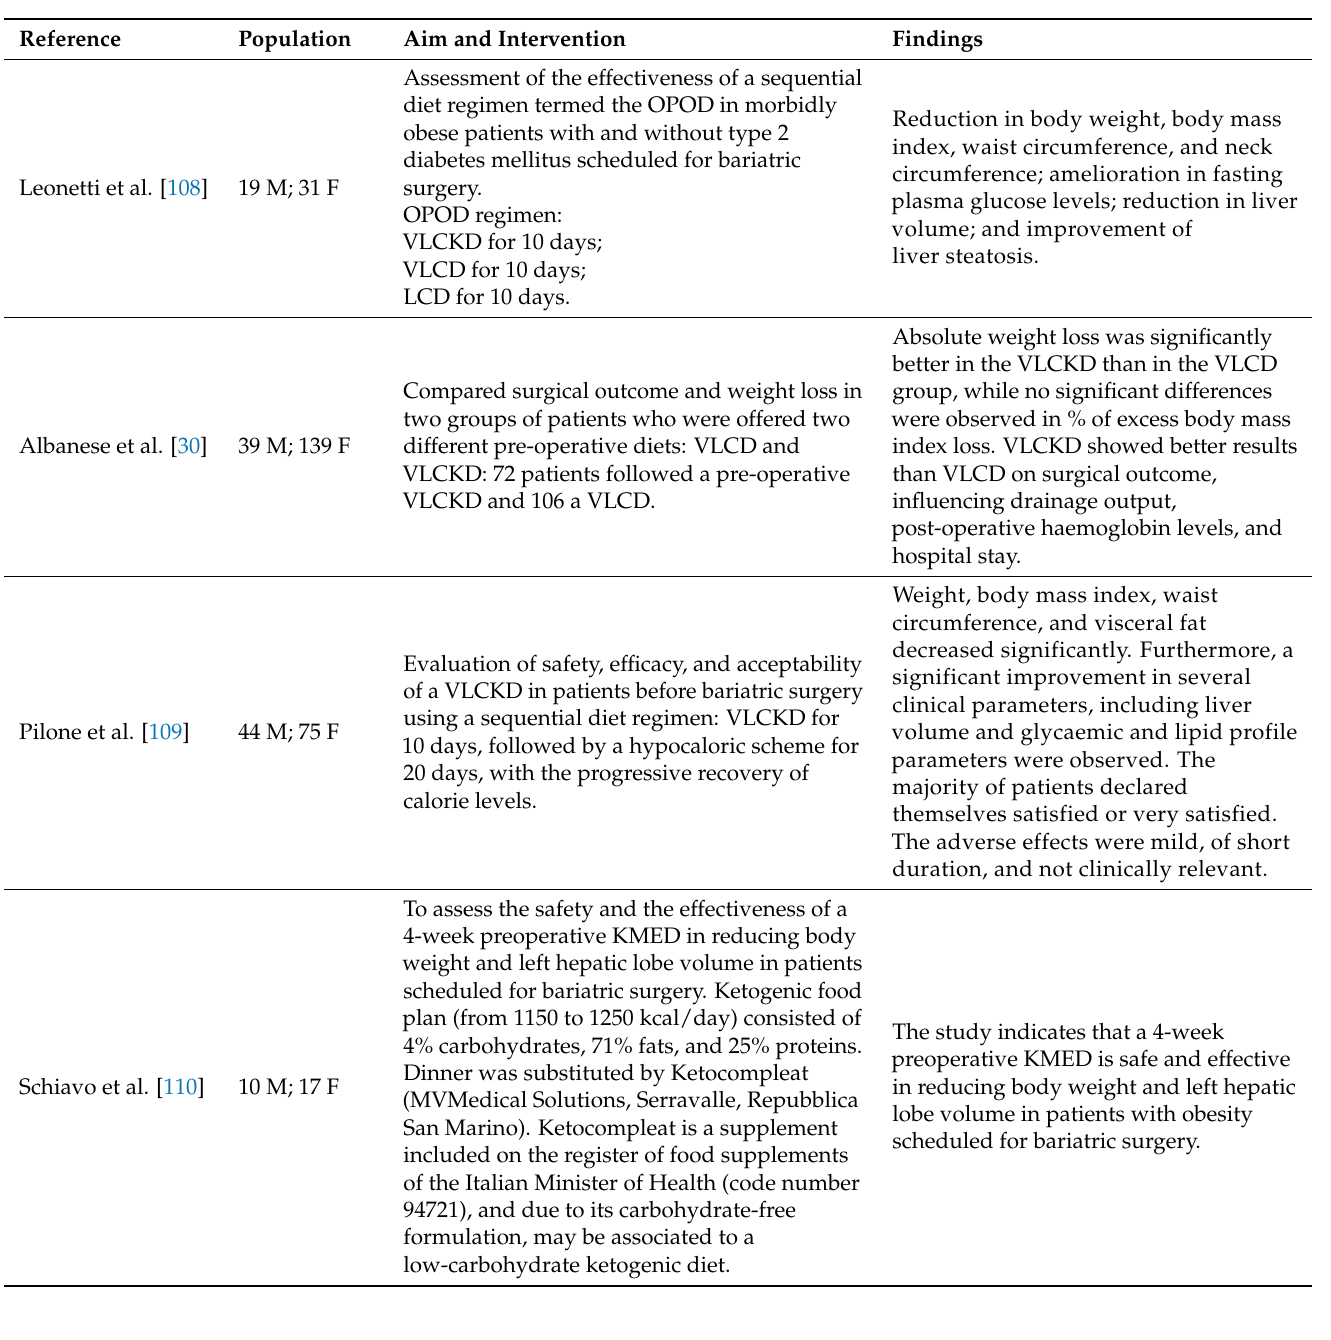
Table 4. Main findings of studies on ketogenic diet before bariatric